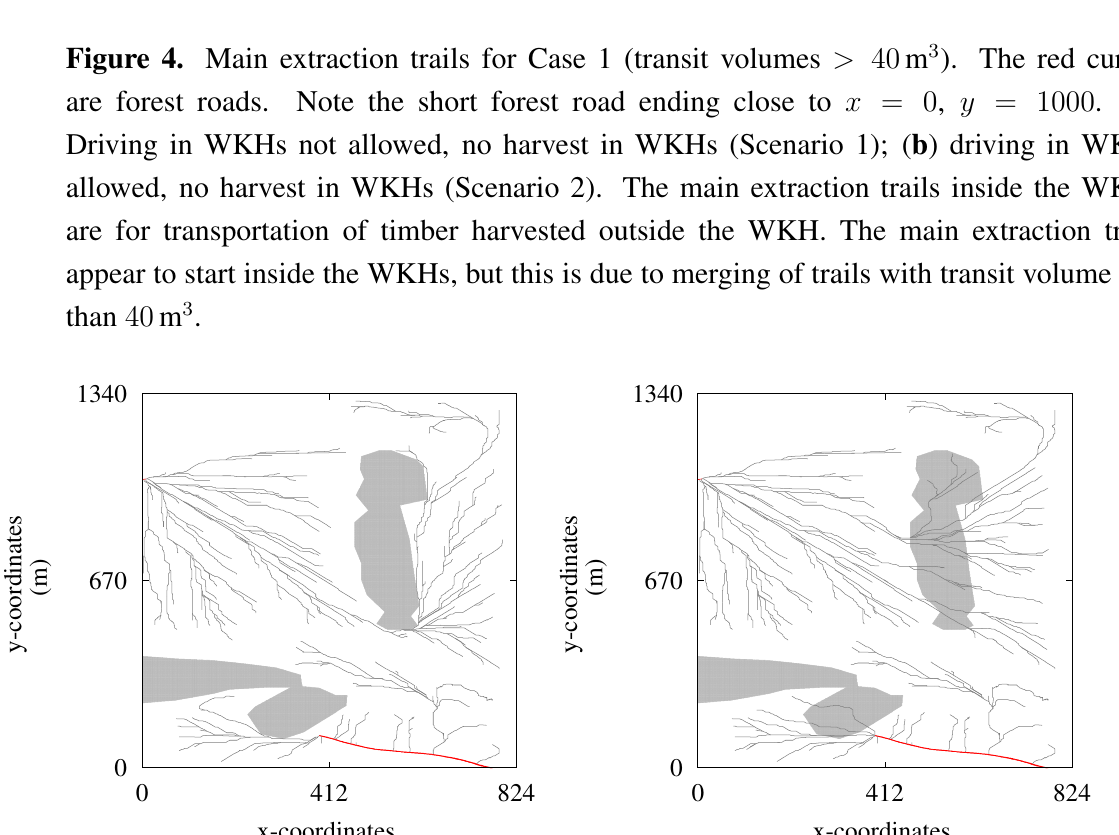
Figure 4. Main extraction trails for Case 1 (transit volumes > 40 m 3 ). The red curves are forest